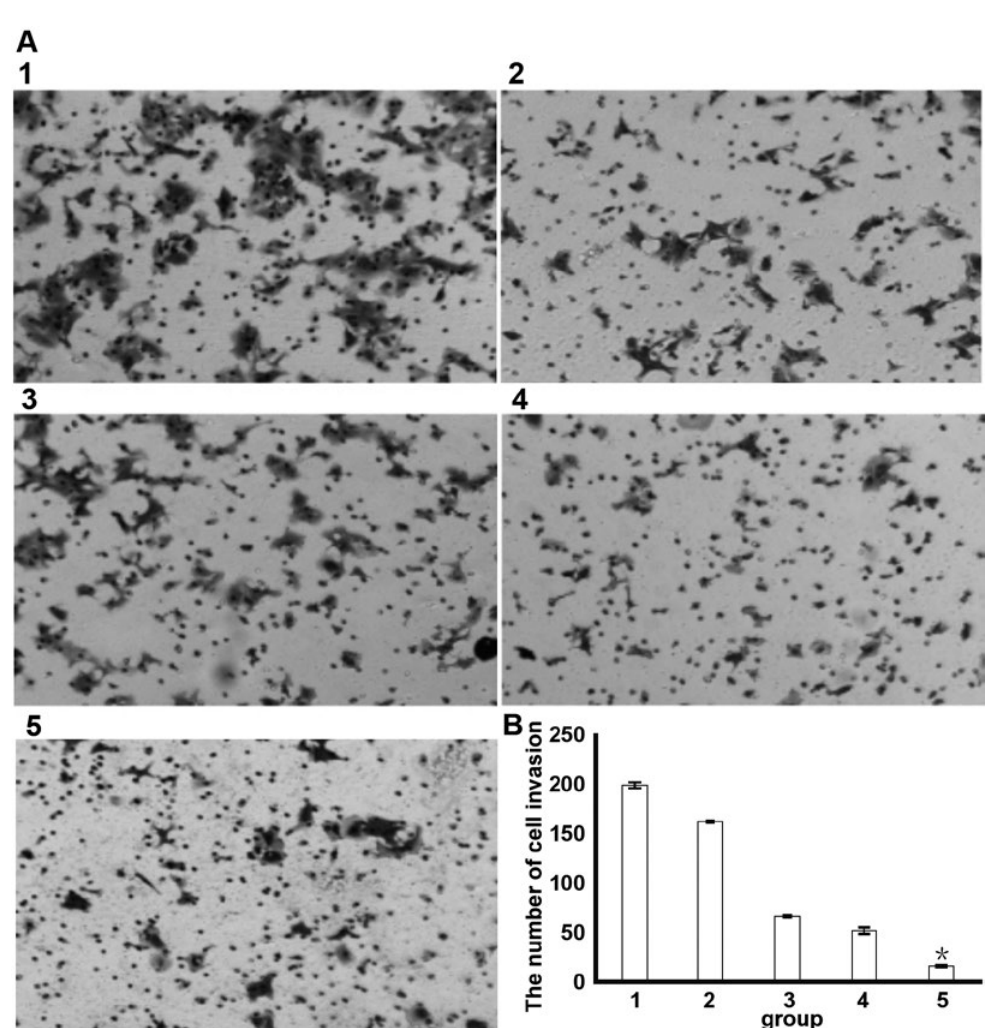
FIGURE 3 - The migration ability of SW480 cells was detected by transwell assay. A: The cell migration distance of each group after treatment for 24 h or 48 h was observed under fluorescence microscope (40X); C: The quantitative analysis of of the wound healing rates in each group after treatment for 48hrs. Mean ± SD. n = 3. * P <0.05, * * P